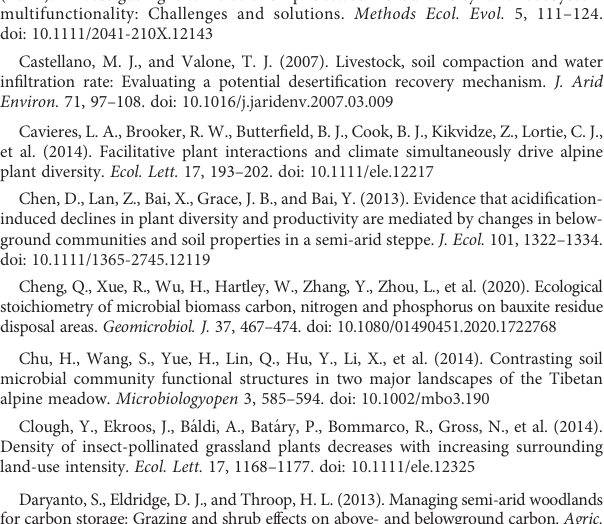
Structural equation model assessing the direct and indirect effects of dominant plants on averaged ecosystem multifunctionality (A) , 25% threshold-based (C) , 50% threshold-based (E) and 75% threshold- based (G) ecosystem multifunctionality via abiotic factors (soil water content and pH) and biotic factors (nematode, plant and microbial biomass). Numbers adjacent to arrows are indicative of the effect size of the relationship. Only signi fi cant and marginally signi fi cant pathways were shown. Signi fi cance levels are as follows: (cid:129) , p < 0.10; *, p < 0.05; **, p < 0.01; ***, p < 0.001. The right panel of the fi gure showed that total, direct and indirect standardized effects of the different drivers of